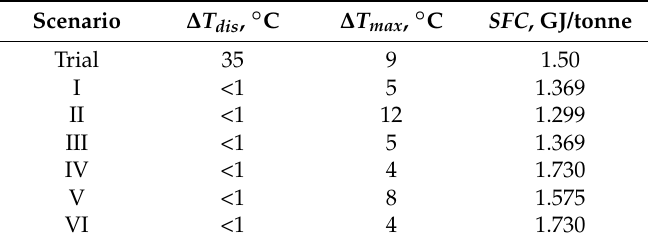
Table 4. Heating performance of different optimisation